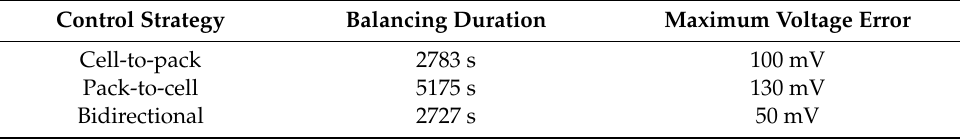
Table 5. Comparison among three measured results of balancing processes.